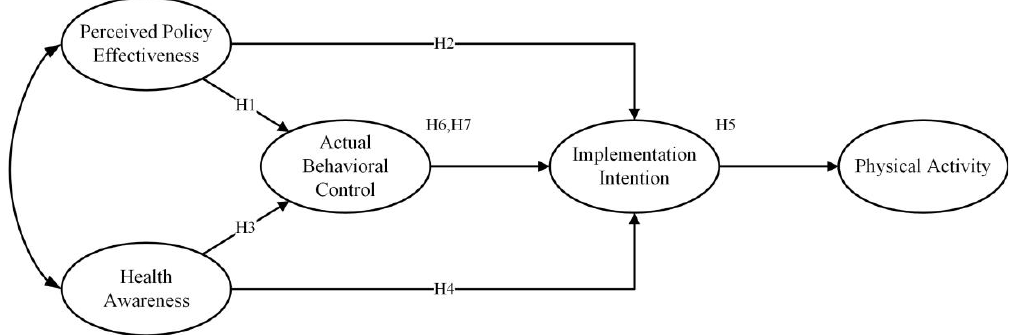
Figure 1. Conceptual